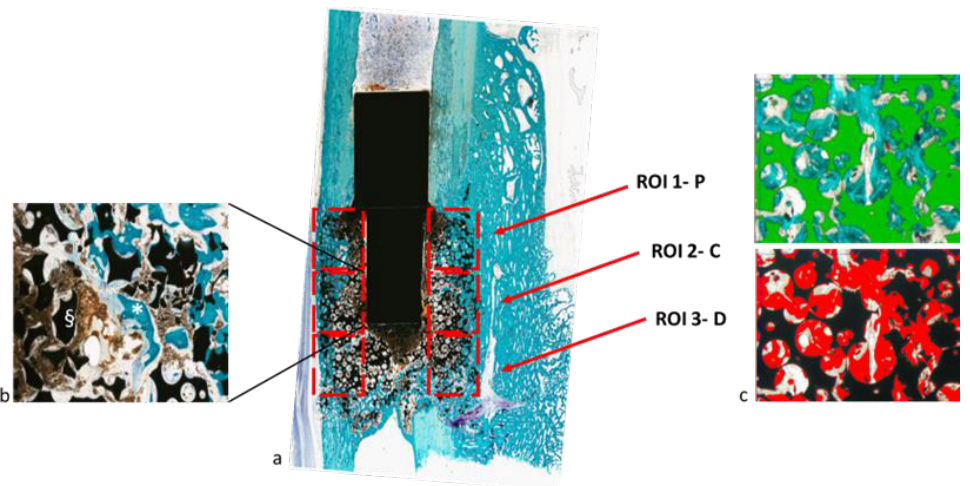
Figure 8. Representation of the regions of interests (ROIs) proximal (P), central (C) and distal (D) identified for histomorphometrical measures, 2x magnification ( a ). Representative high magnification of a ROI in which bone (*) and material (§) are marked ( b ). Snapshot of the Leica Qwin software showing the binarization process for image segmentation to identify the material (in green) and the bone (in red) ( c ).